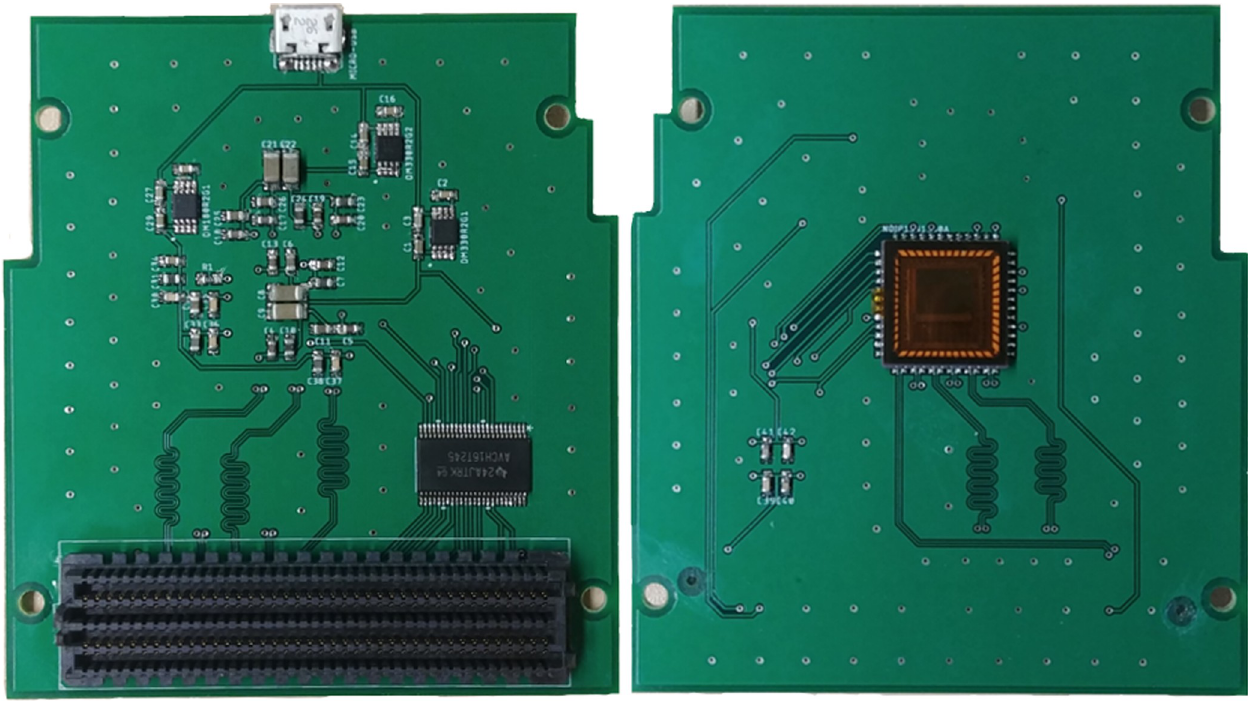
Fig 2. PYTHON 1300 camera sensor PCB design with an FMC